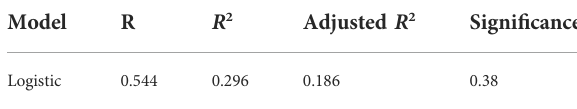
TABLE 1 Statistical table of model parameters (the gas-liquid two- phase fl ow